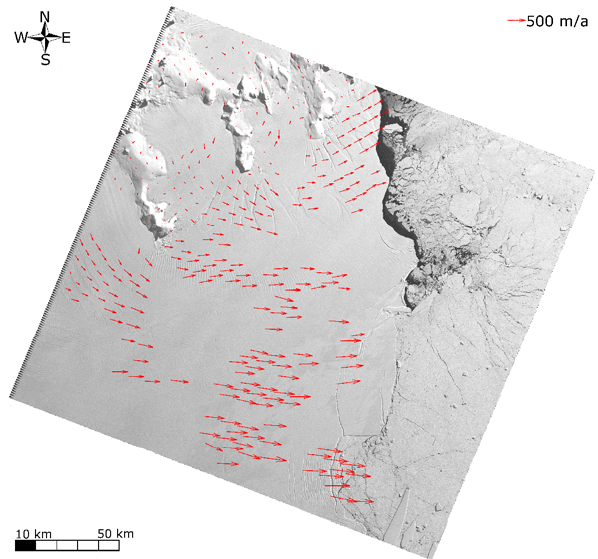
Fig. 6. Average annual velocity between 2006 and 2008 measured with orientation correlation on Landsat 7 ETM+ pan images from path 216 row 107 over Larsen C North. Underlying Landsat image of 2002.